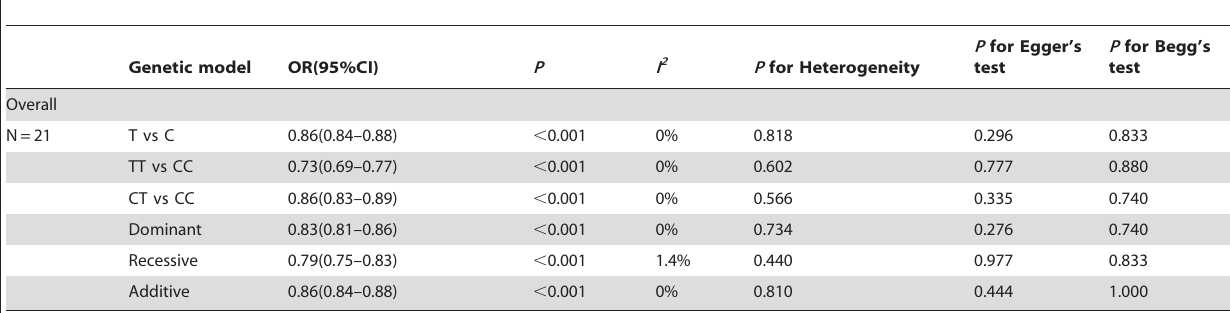
Genetic model OR(95%CI) P I 2 P for Heterogeneity